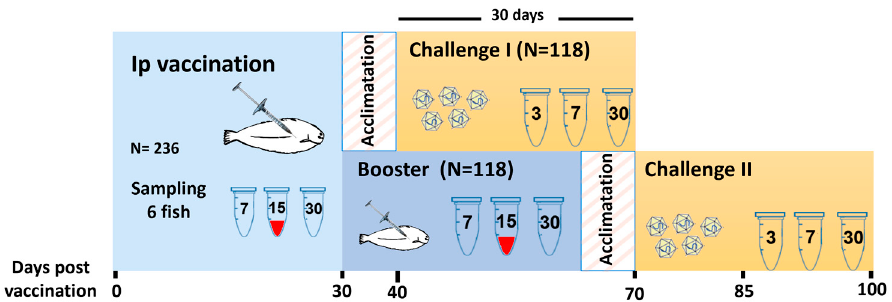
Figure 2. Experimental design. After arrival to the USC aquarium facilities, fish were acclimated for 10 days before challenge. Mock-vaccinated individuals were handled and sampled as vaccinated